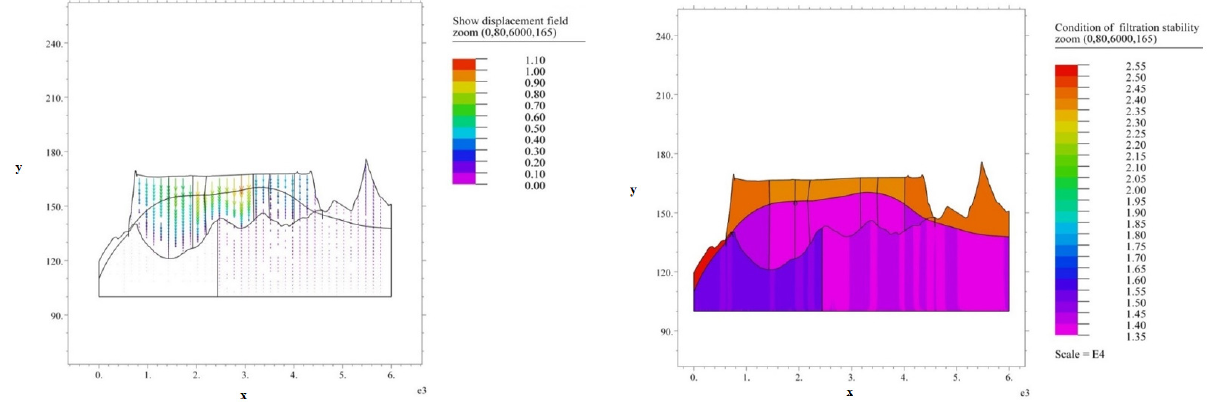
Figure 4: Results for the 2D model – land dislocations.